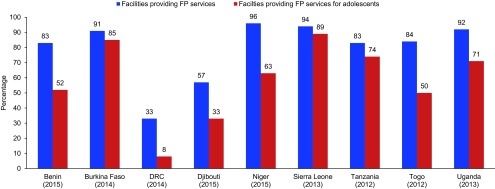
Percentage of Health Facilities Providing Family Planning Services to Unmarried AdolescentsAbbreviations: DRC, Democratic Republic of the Congo; FP, family planning.